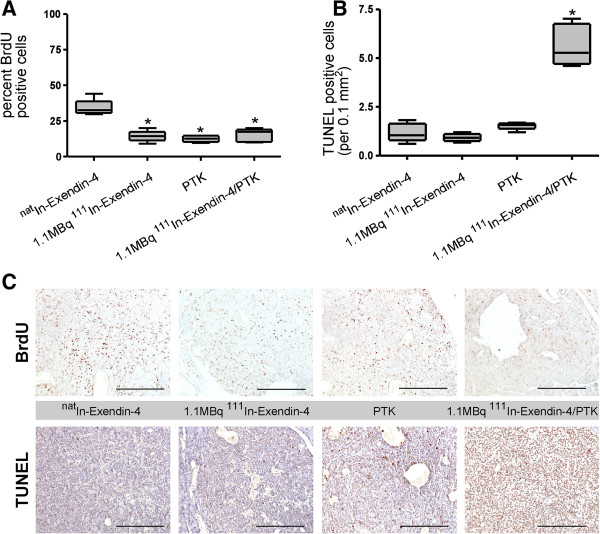
Proliferation and apoptosis of tumor β-cells treated with [Lys40(Ahx-DTPA-111In)NH2]-exendin-4 and/or vatalanib. (A) Treatment of mice with 1.1 MBq [Lys40(Ahx-DTPA-111In)NH2]-exendin-4, vatalanib, and the combination therapy induces a significant decrease in tumor cell proliferation (***p < 0.001, Newman-Keuls post-test). However, there is no significant difference between the three interventional groups. (B) In contrast, tumor cell apoptosis is significantly increased in the combined treatment group as compared to all the other groups (***p < 0.001, Newman-Keuls post-test). (C) Immunohistochemical staining for BrdU (proliferation, top row) and TUNEL (apoptosis, bottom row). Size bars, 100 μm.